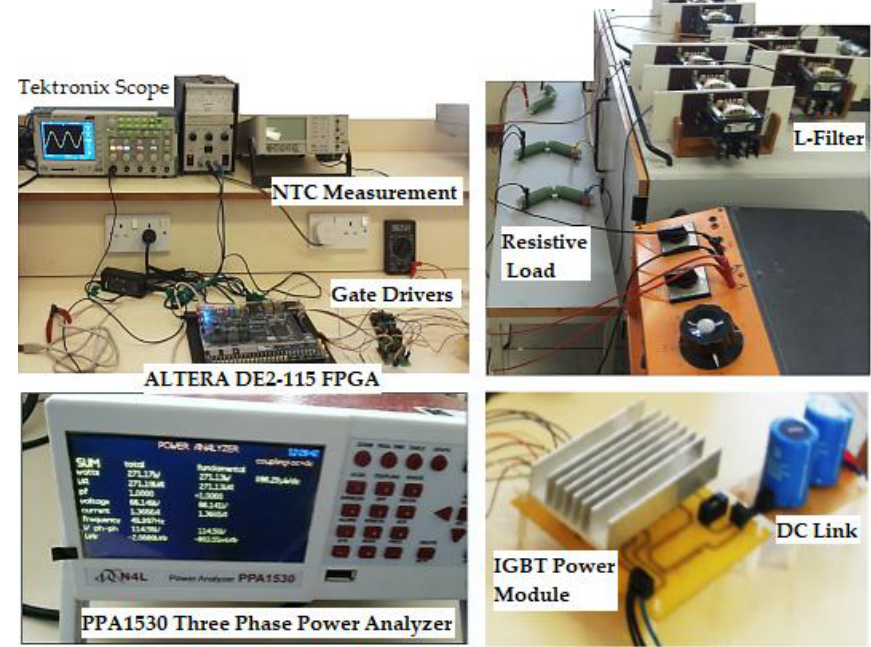
Figure 10. Experimental setup.